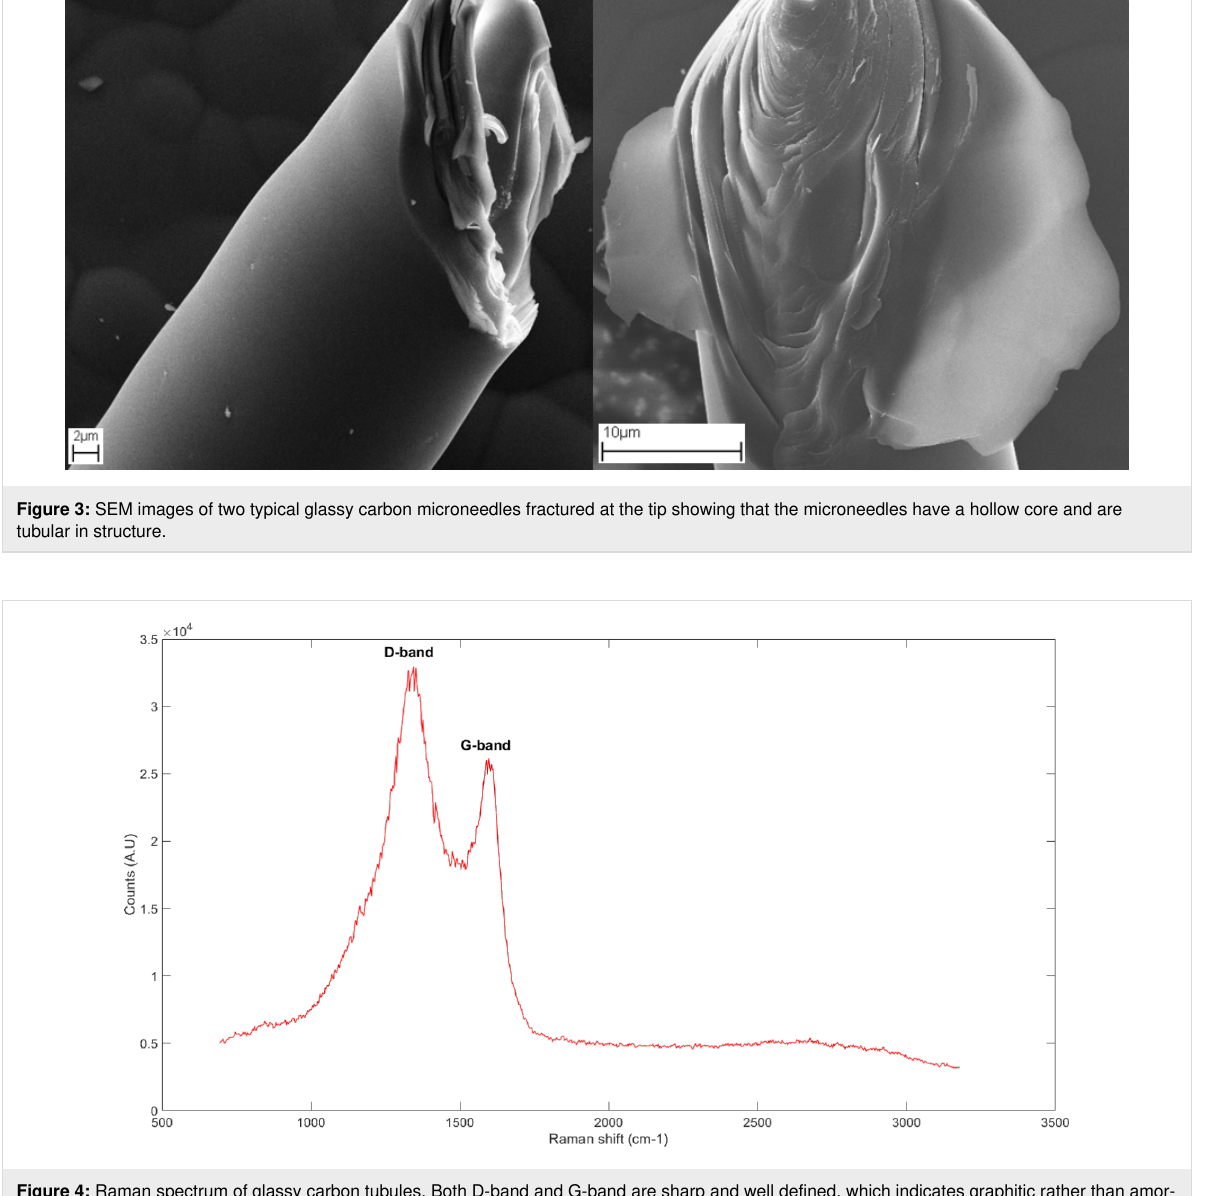
interlayer spacing of graphite and other selected carbon materi- als and is further evidence that the tubules are glassy